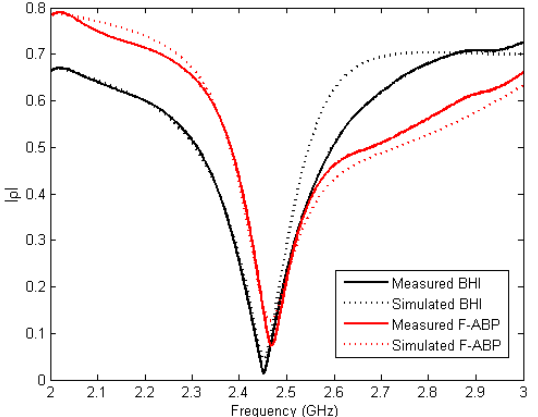
Figure 7. Measured and simulated reflection coefficient for BHI and F-ABP.